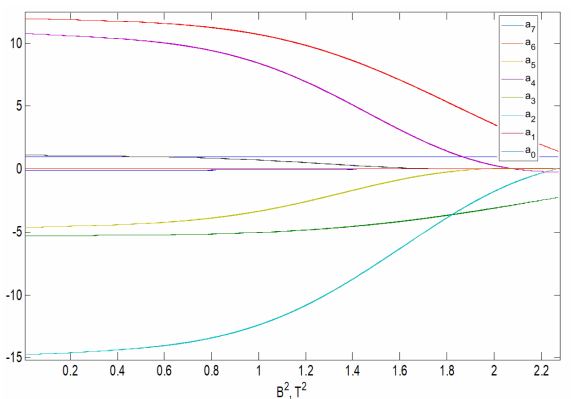
Figure 5. The diagram presents general dependency of the changeability of polynomial coefficients that comprise the numerator of the developed IIR filter in the domain of Laplace variable s , in the function of B 2 .